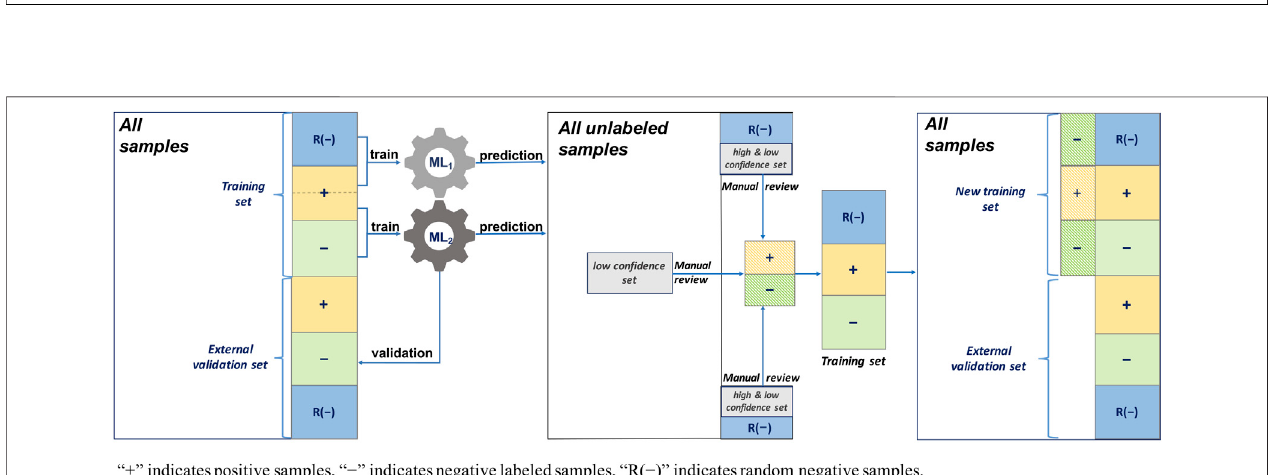
FIGURE 5 | Active learning work fl ow with two separate ML algorithms, uncertainty sampling plus random negative sampling, and no validation update.